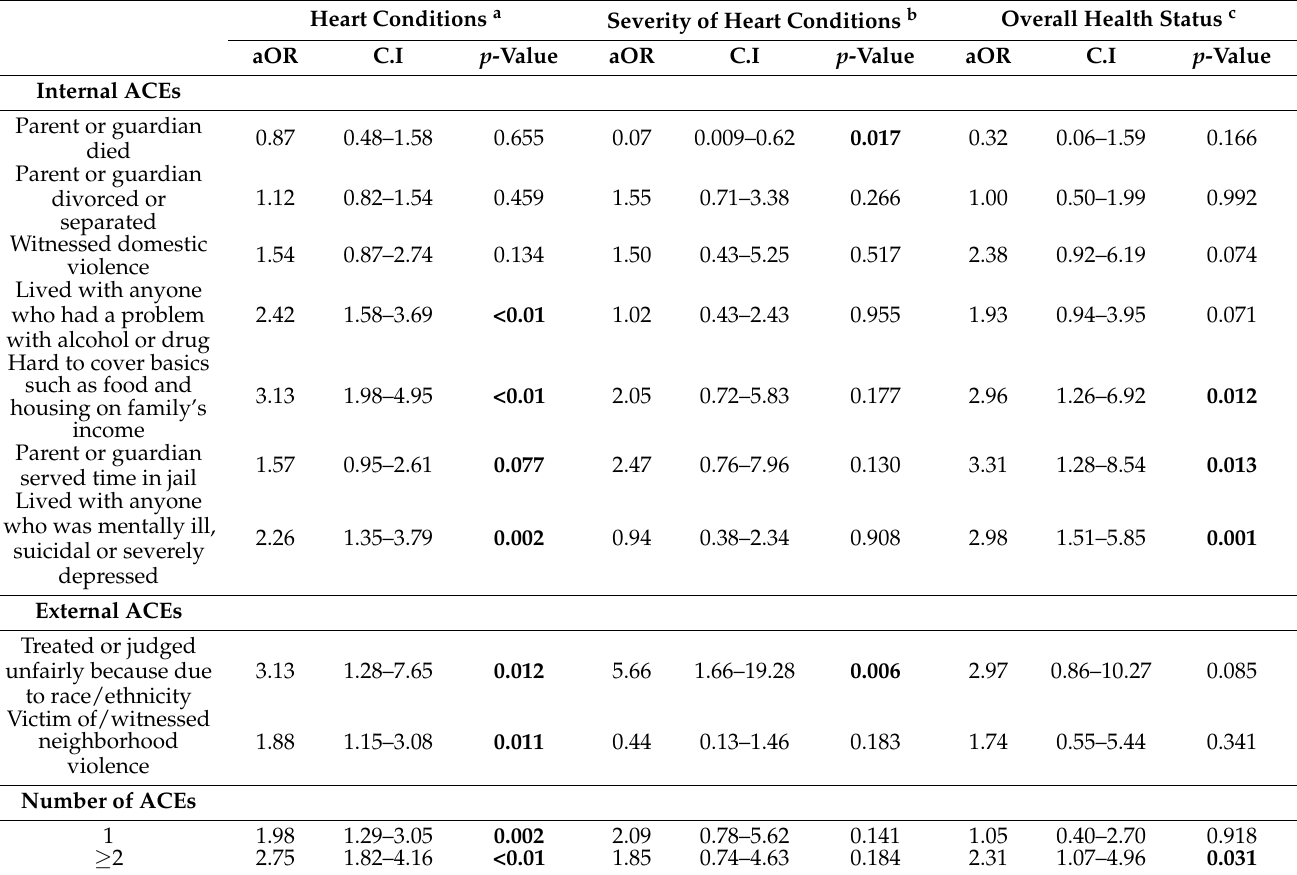
Table 3. Multivariate logistic regressions of ACEs and different